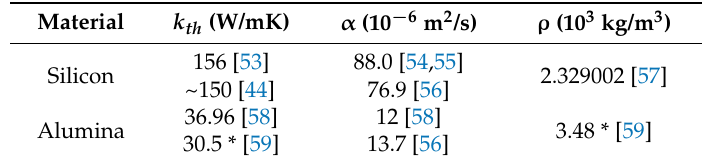
Table A2. Thermal material data for silicon, alumina and lead oxide.